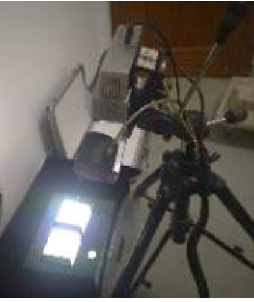
Figure 2: Surface morphometer.